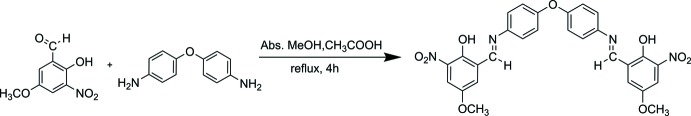
Reaction scheme for the synthesis of the title compound.